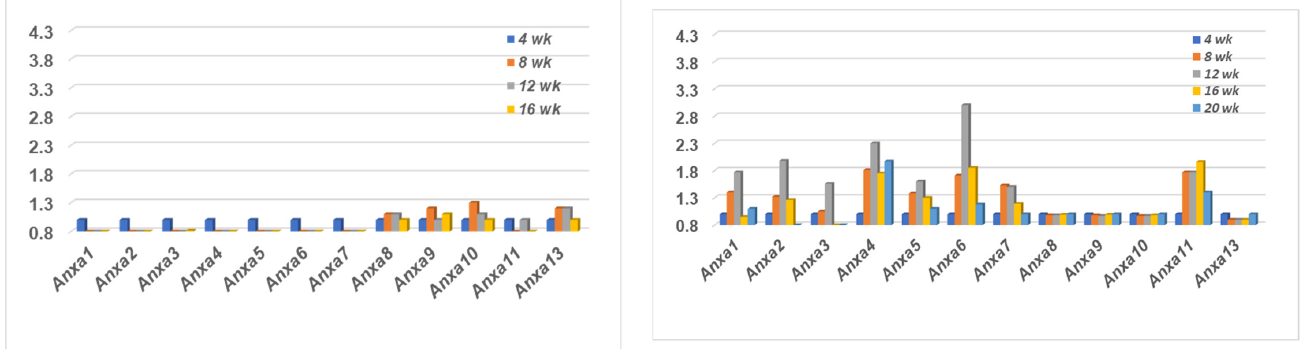
Figure 1. Transcriptome profiles of genes encoding the annexin family proteins. Temporal transcriptomic expressions of annexin genes in the salivary glands of SS NS C57BL/6J ( left panel) and SS S C57BL/6.NOD ‐ Aec1Aec2 mice ( right panel) showing completely opposing profiles.